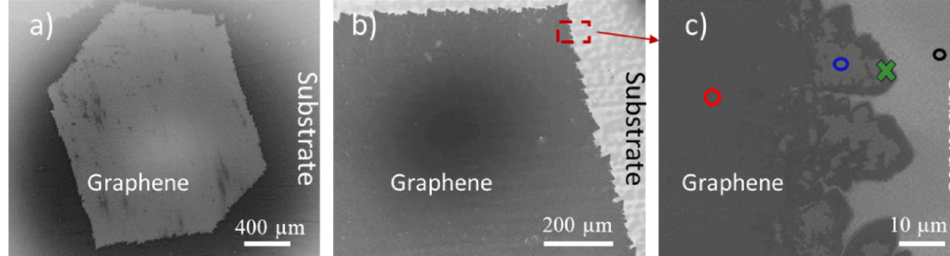
Figure 1. Graphene monocrystal with post-growth annealing before transfer, ( a ) SEM image of a hexagonal monocrystal ( b ) edge of the graphene monocrystal, ( c ) magnified area framed in red in panel b, showing one graphene edge close to which Raman spectra were measured (colored marks).